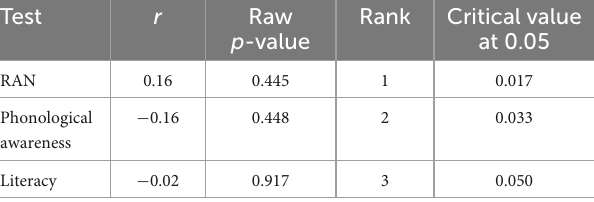
TABLE 5 Correlations in the dyslexia group between the test performance and MMN amplitude change after training with the game. Test r Raw Rank Critical value p -value at 0.05